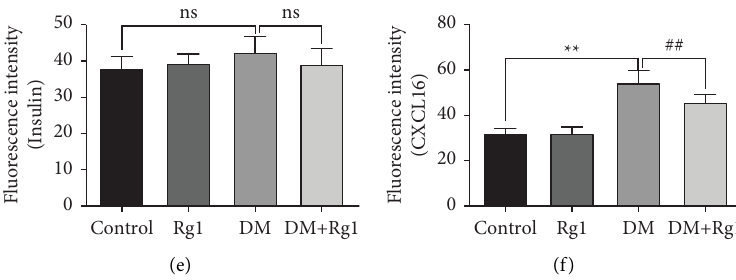
Figure 3: Expressions of CXCL16, CD45, and insulin receptor (INSR) proteins in the pancreas by immunofuorescence ( × 400, scale: 50 μ m, mean ± SD, n � 6) (a–c) the expressions of CXCL16 and CD45 proteins’ colocalization in the pancreas. (d–f) Te expressions of INSR and CXCL16 proteins colocalization in the pancreas. Te fuorescence intensity was detected to observe the protein expression. Te increase in CD45 indicated an increase in infammatory cell infltration. Tose results suggested that Rg1 treatment improves infammation of the pancreas in type 1 diabetes mice relating to reducing CXCL16. ∗∗ p < 0 . 01, vs. the control group; ## p < 0 . 01 vs. the DM group.